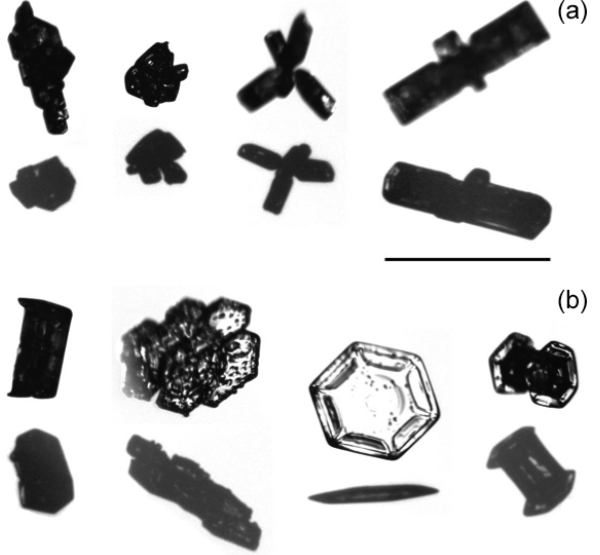
Figure 7. Ice particles as imaged in two viewing geometries: top view and side view. Each ice particle is shown as a pair of these two views, with the top view always above the corresponding side view. Eight particles are shown in two rows (a, b) of such pairs. All images have the same resolution; for reference, a size bar with length corresponding to 1mm is shown.